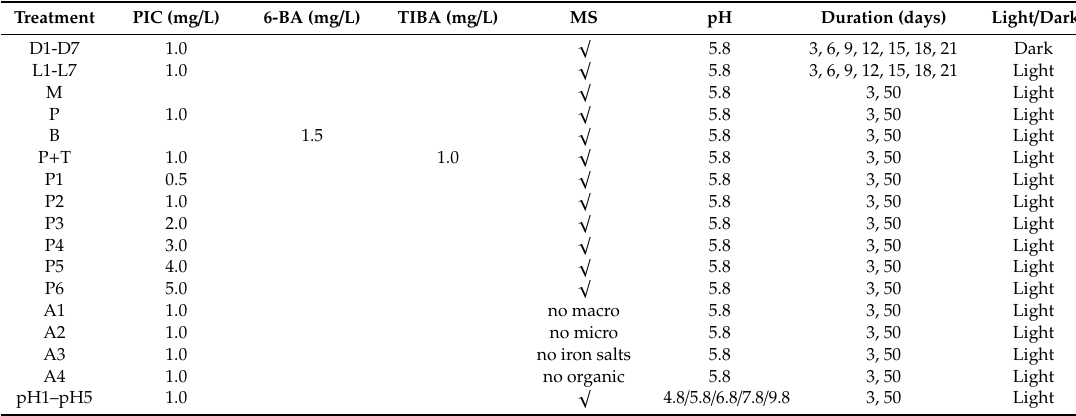
Table A1. The media component for di ff erent